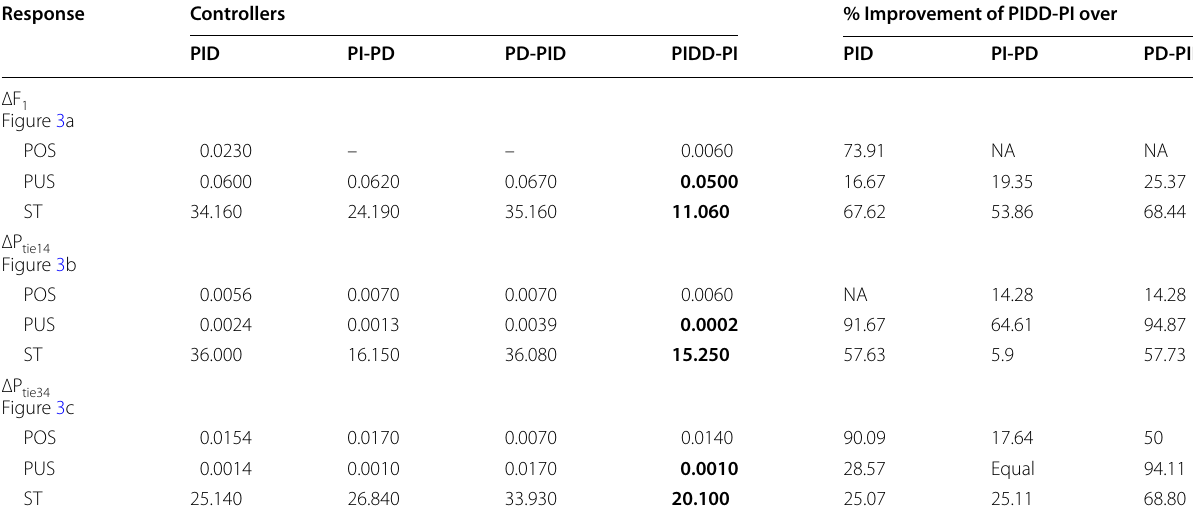
Bold representes the best values obtained with PIDD - PI controller when compared with the other comtrollers tabulated such as PID, PI-PD, PD-PID